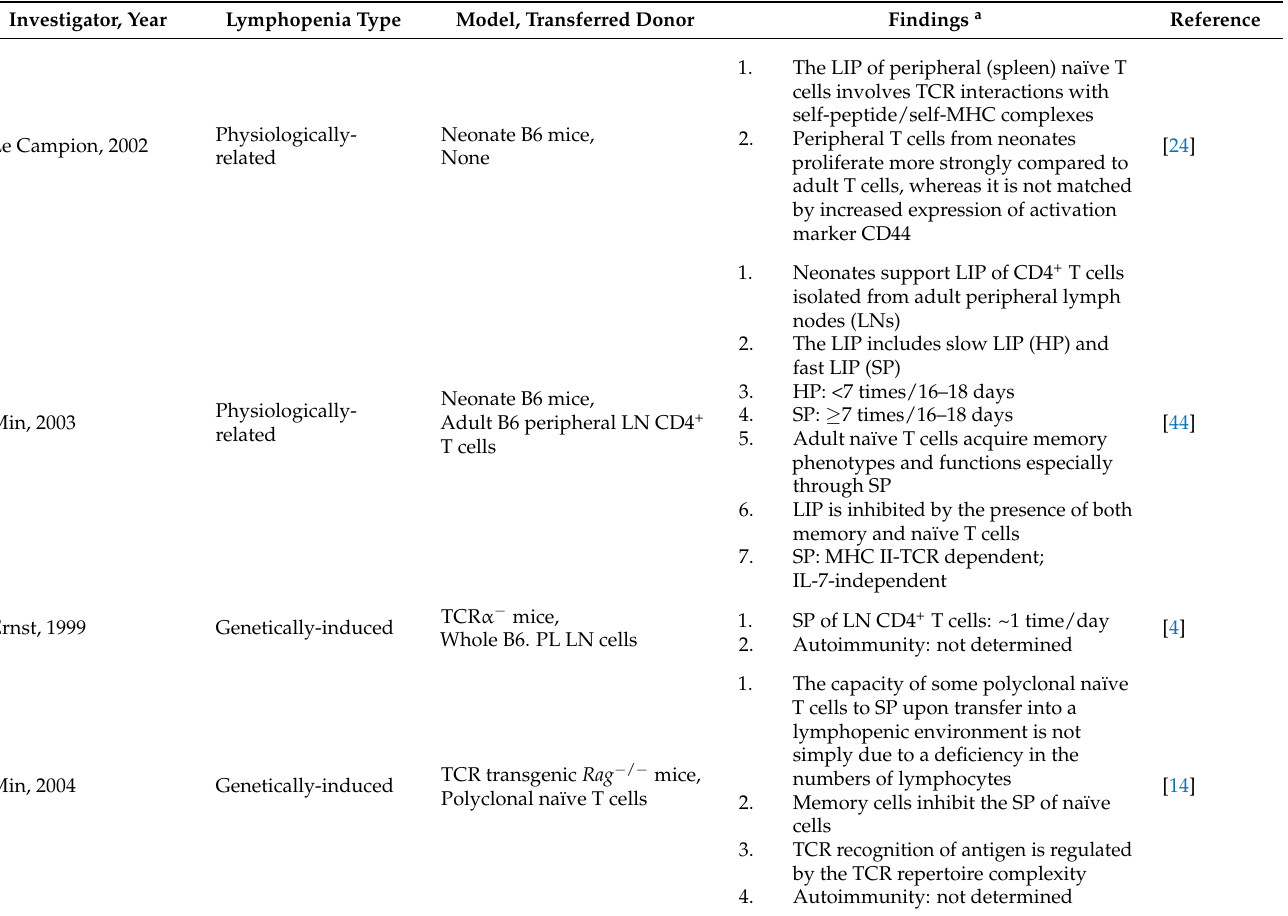
Table 2. LIP and its presence in physiological and autoimmune